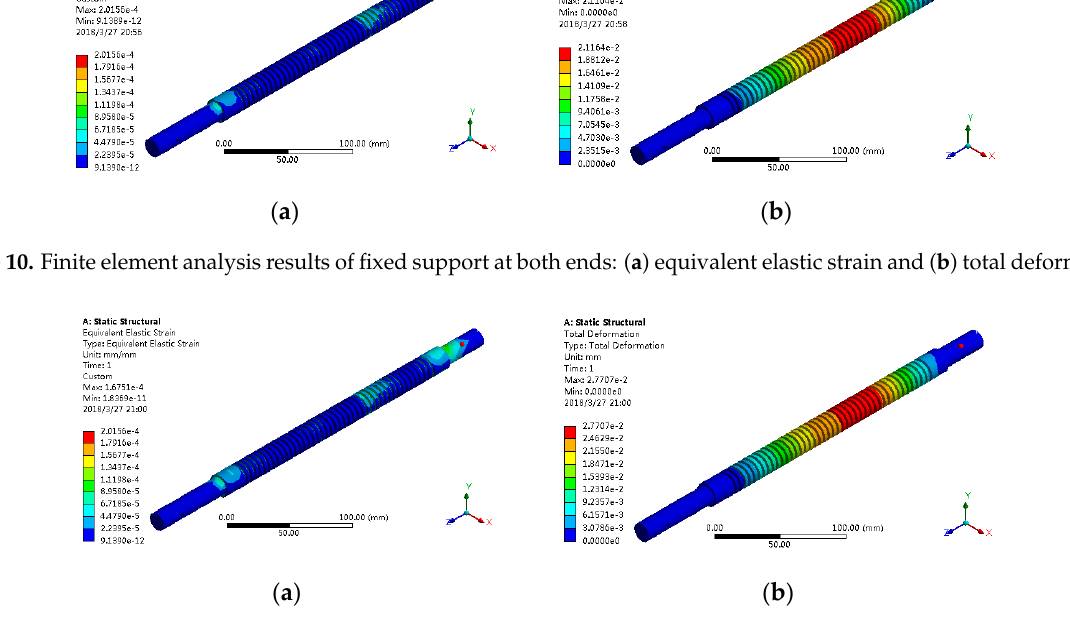
Figure 11. Finite element analysis results of one end fixed and one end supported: ( a ) equivalent elastic strain and